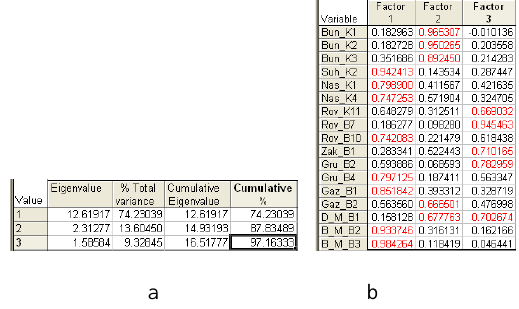
Table 5. a) The value of the principal components and b) factor loadings after varimax rotation of three factors.